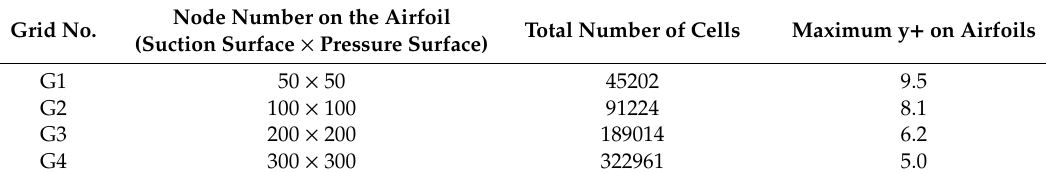
Table 4. Details of four computational grids.